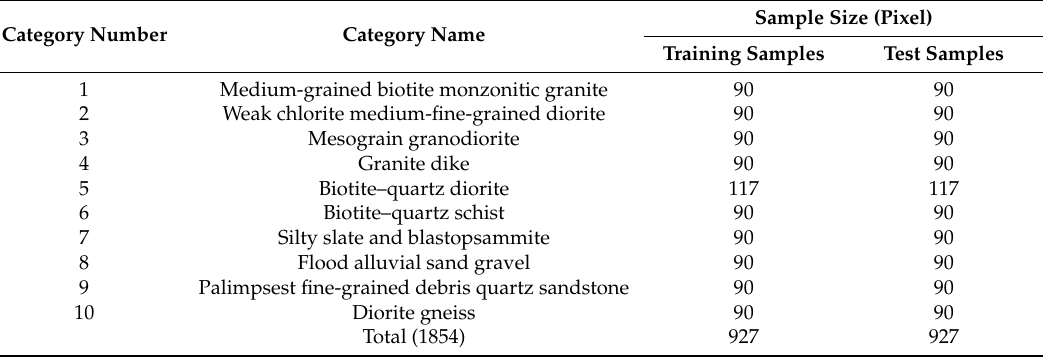
Table 2. Sample data statistics.